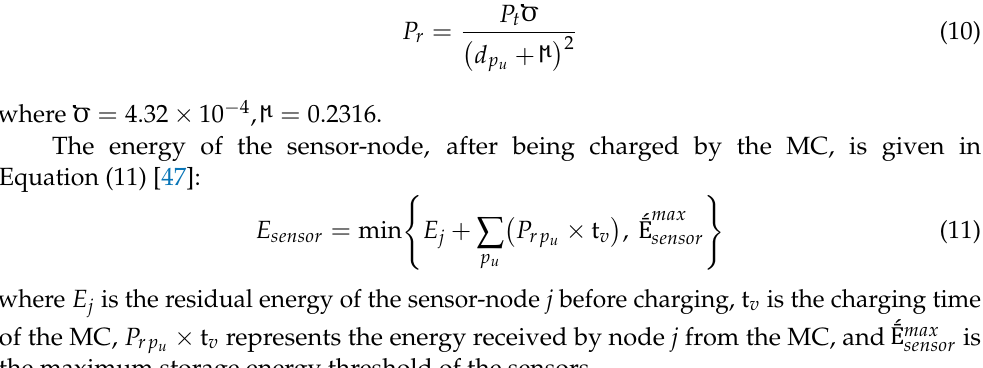
Figure 5. Number of alive nodes over time for different MC initial energy percentages.